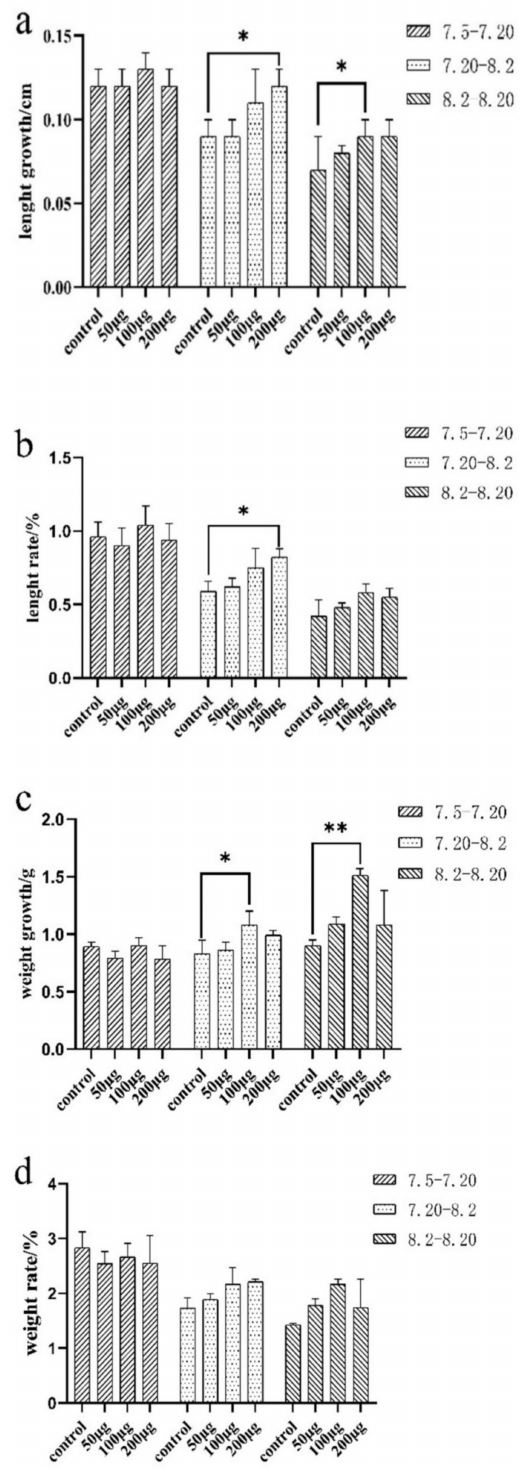
Figure 2. Growth and rate of length and weight of E. coioides. ( a ) Growth of the length of E. coioides ; ( b ) rate of the length of E. coioides ; ( c ) growth of the weight of E. coioides ; ( d ) rate of the weight of E. coioides . Bar: mean ± SD. * p < 0.05 and ** p < 0.01 unpaired t test, n =